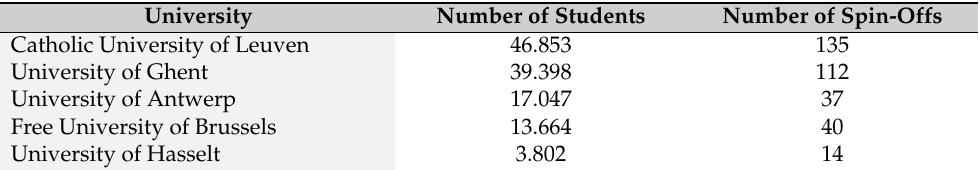
Table 3. Overview of students and spin-offs per Flemish university in the academic year of 2019–2020 (Vlaanderen